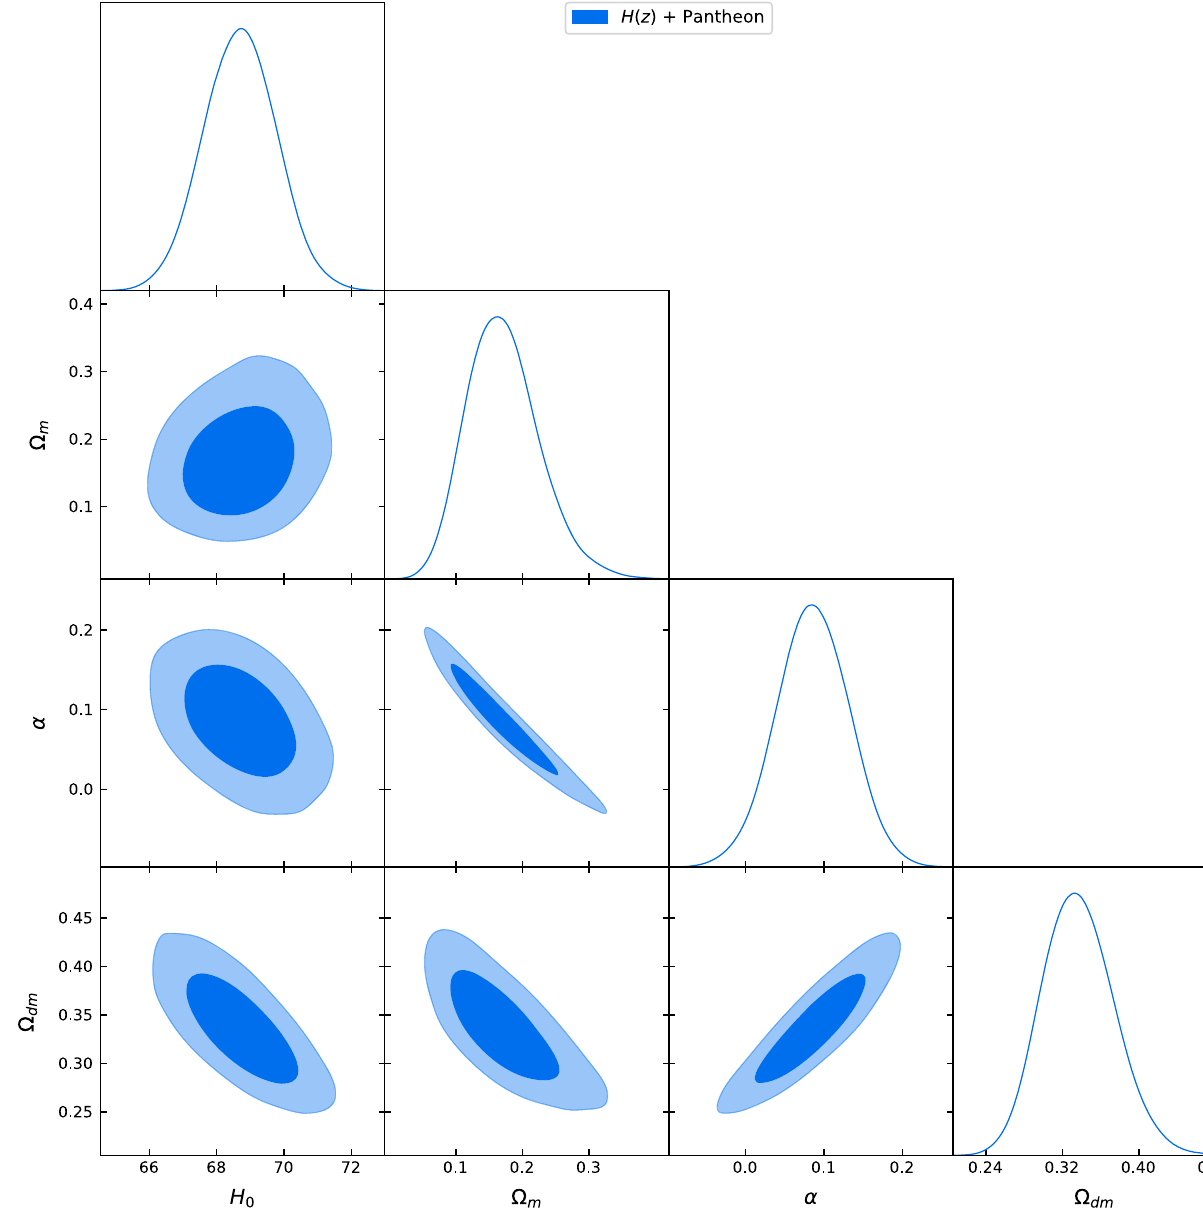
Fig. 2 Joint analysis using SNe Ia – Pantheon and 51 H ( z ) data, for the constraints of the main parameters, H 0 , (cid:7) m and α and for the derived parameter (cid:7) dm , for Case I